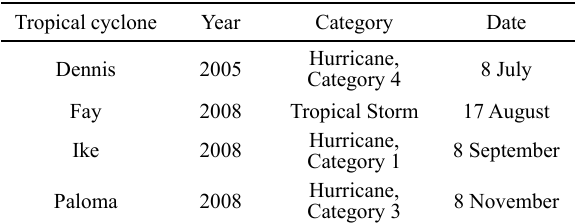
Table 2. – Tropical cyclones that have affected the JRNP in the present century